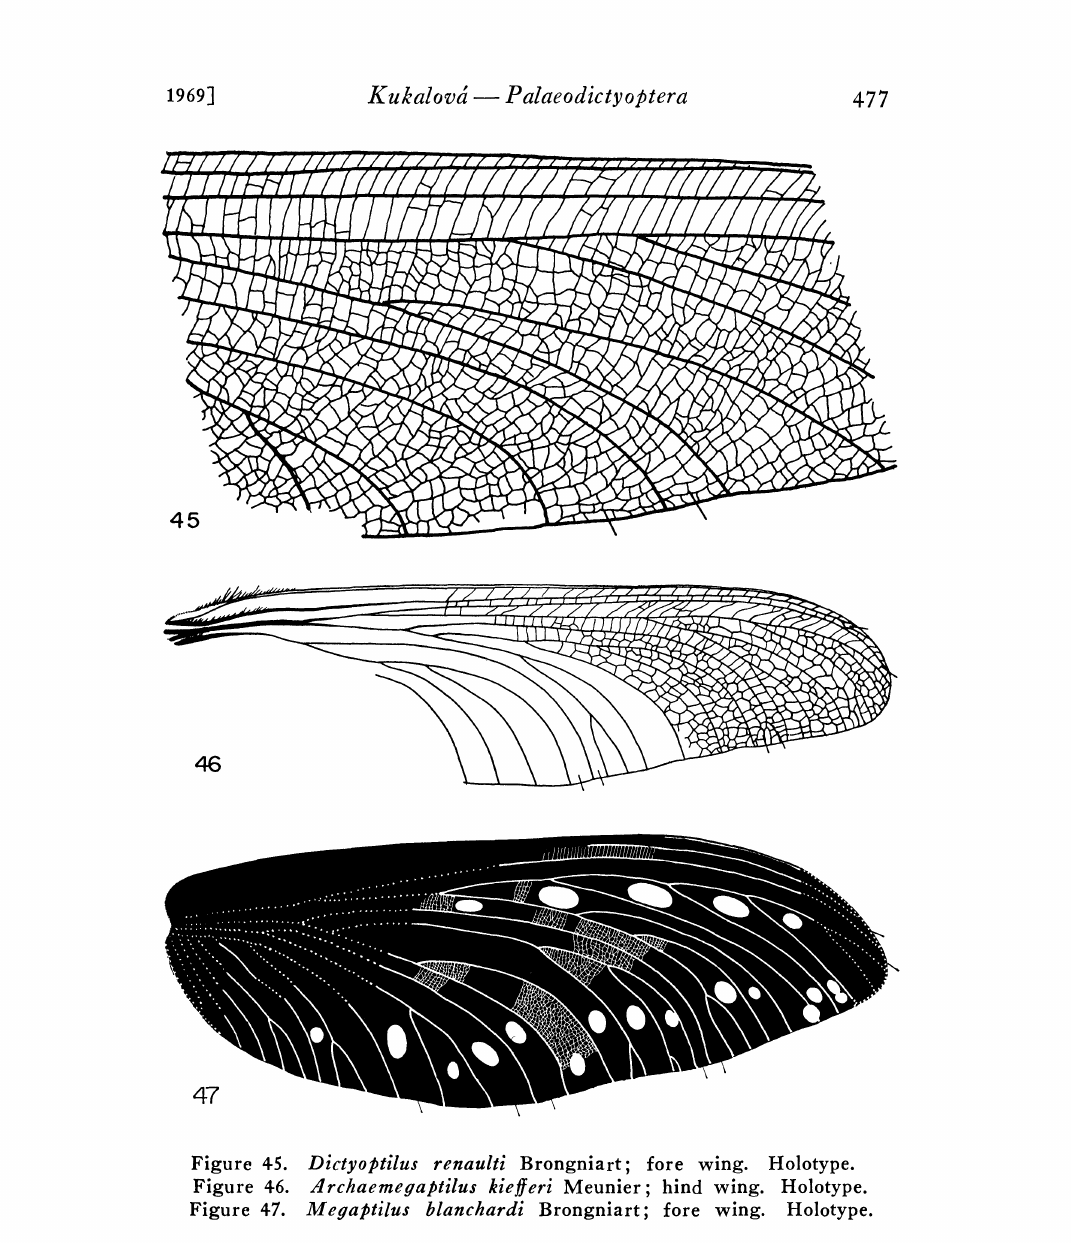
Figure 45. Dic’tyoltilus renaulti Brongniart; fore wing. Holotype. Figure 46. zlrchaemegaktilus kiefferi Meunier; hind wing. Holotype. Figure 47. Megaltilus blanchardi Brongniart; fore wing.